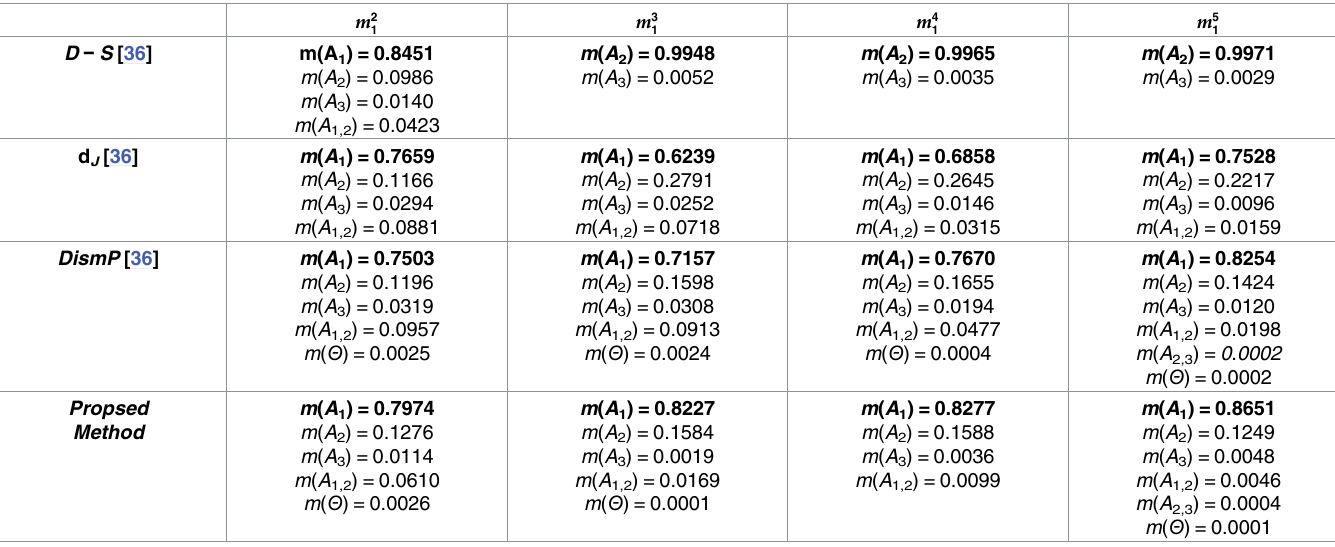
Table 2. Comparison results of different